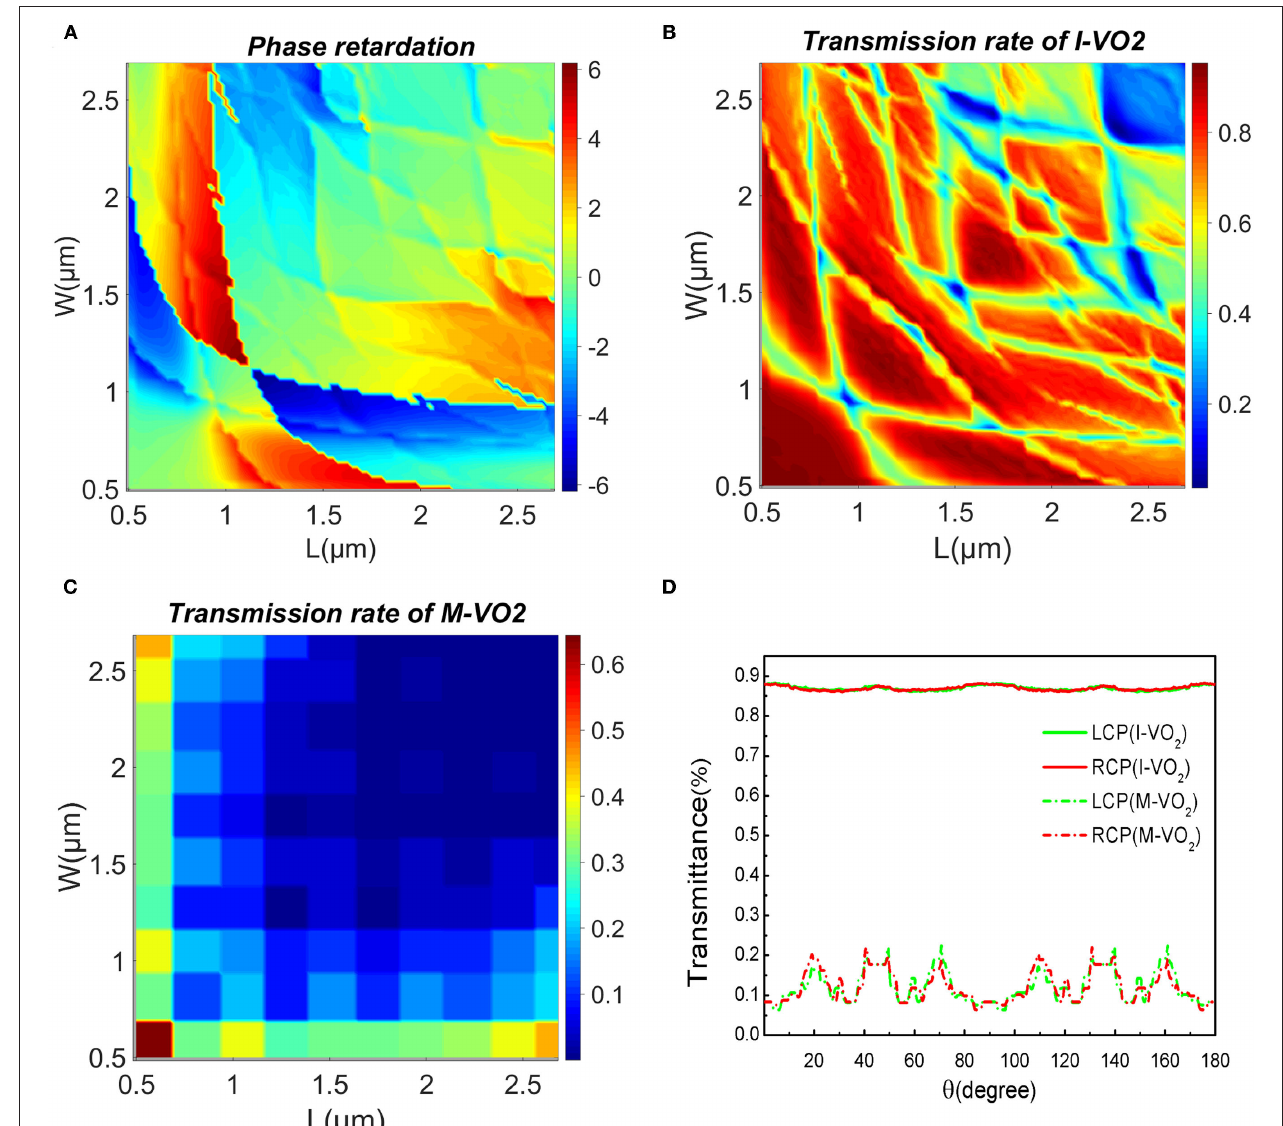
FIGURE 4 | (A) Phase shift corresponding to each unit with different L and W at the state of I-VO 2 . (B) and (C) represent the scan graph of the transmittance of each unit in the I-VO 2 and M-VO 2 states as a function of L and W, respectively. (D) When the unit cell rotation angle is changed from 0 to 180 ◦ , the transmittance change graph corresponding to the incidence of LCP and RCP.